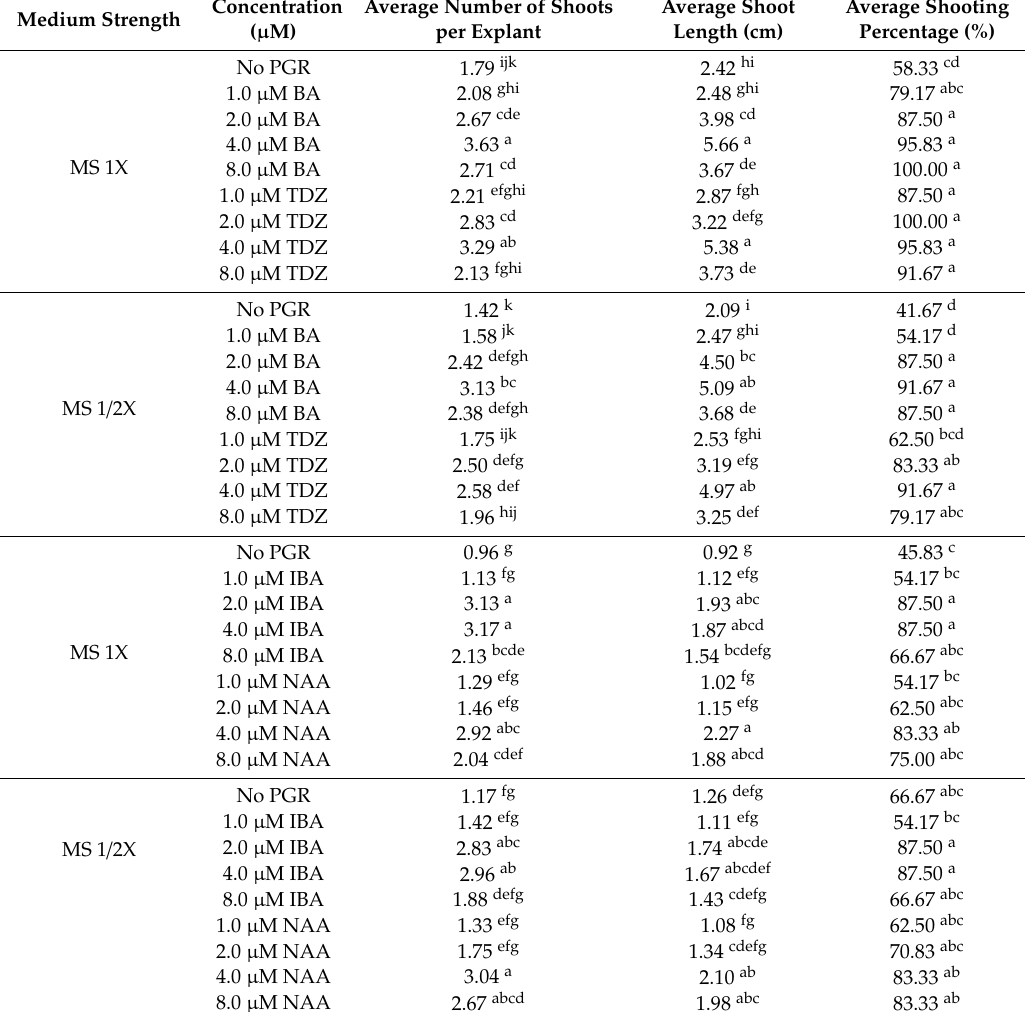
Table 1. The e ff ect of medium strength and plant growth regulators’ concentrations on the average number and length of shoots per explant, shoot formation frequency, as well as on number and length of roots per shoot and rooting percentage of the high cannabidiol (CBD) Cannabis sativa variety. (Means followed by the same letter do not di ff er statistically at p ≤ 0.05 according to Duncan